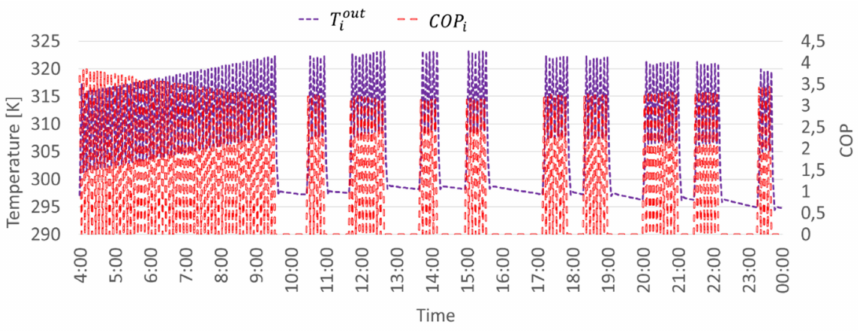
Figure 10. T out vs. COP i values in the relay i